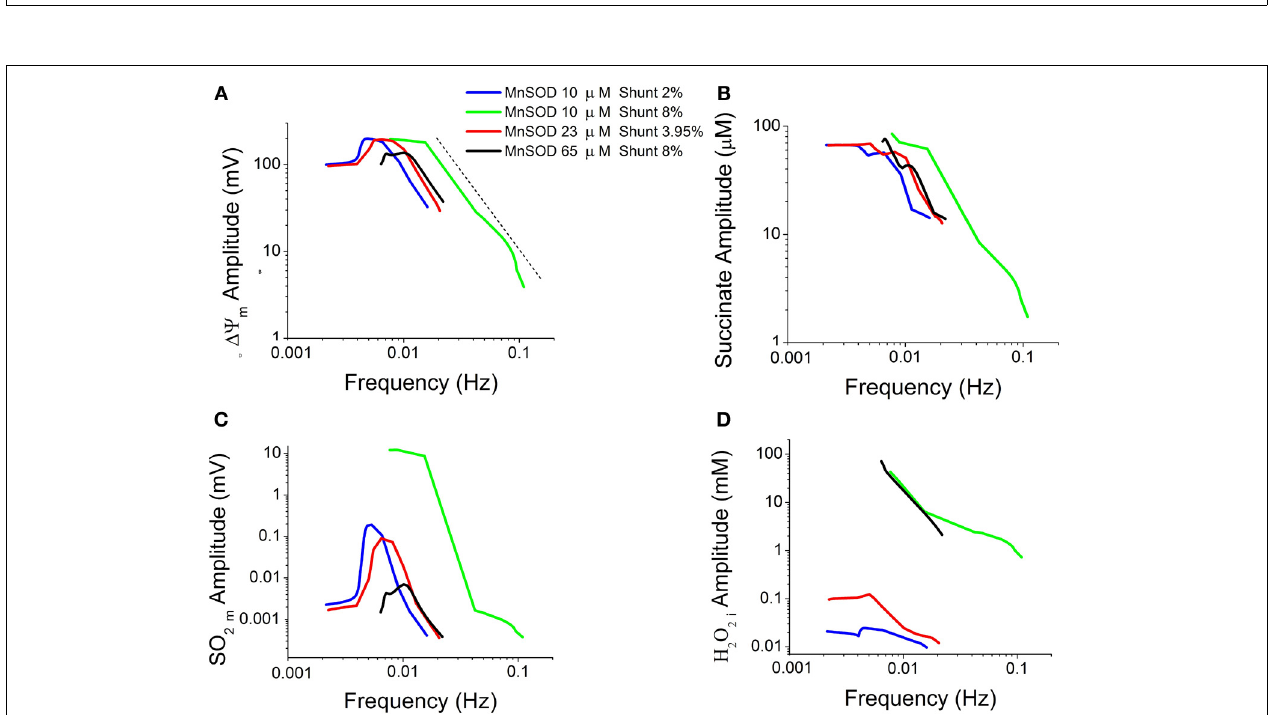
oscillatormayattainthesamefrequency(0.01Hz,or100speriod)withdifferent combinations of the three parameters (MnSOD, CuZnSOD, and shunt) as indicated by the dotted line. (B) Displayed are the time series corresponding to the four parametric combinations shown in (A) at a frequency of 0.01Hz.